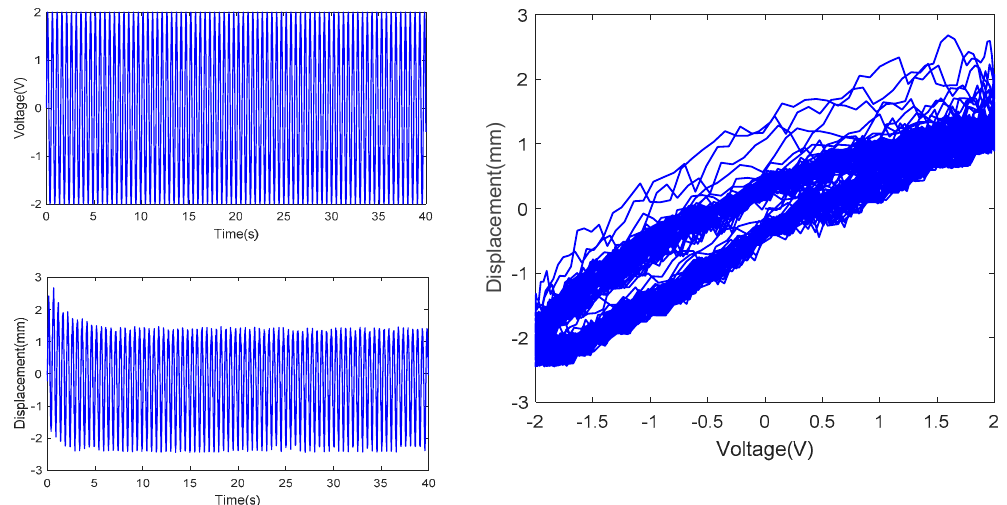
Figure 9. Tip displacement at actuating voltage with amplitude of 2V and frequency of 5/2 π Hz.